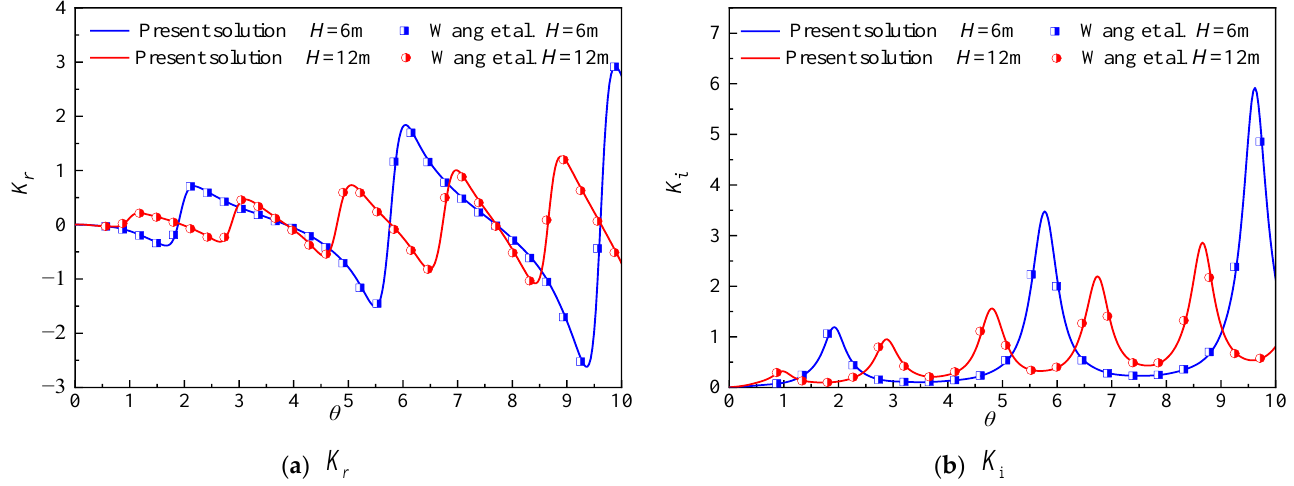
Figure 2. Comparisons of the proposed solution with the solution of Wang et al. [36]. ( a ) K r , ( b ) K i